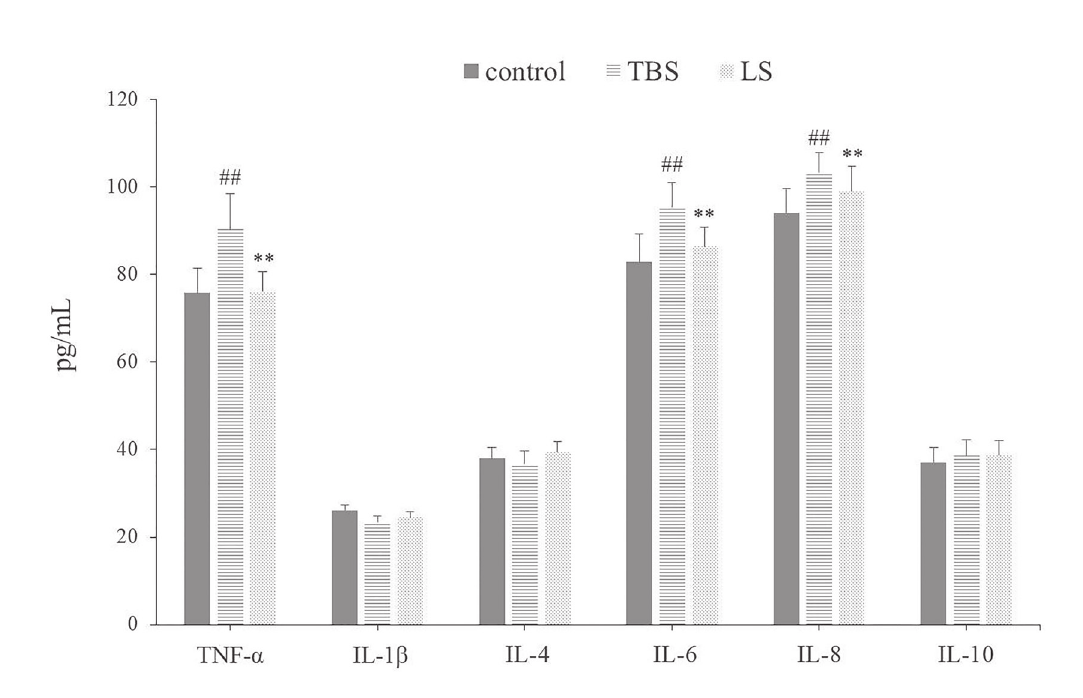
FIGURE 1 - The levels of TNF-α, IL-1β, IL-4, IL-6, IL-8 and IL-10 from rat serum (pg/mL). Data shown are mean ± SD (n = 10 per group). ## p < 0.01 vs control group, ** p < 0.01 vs TBS